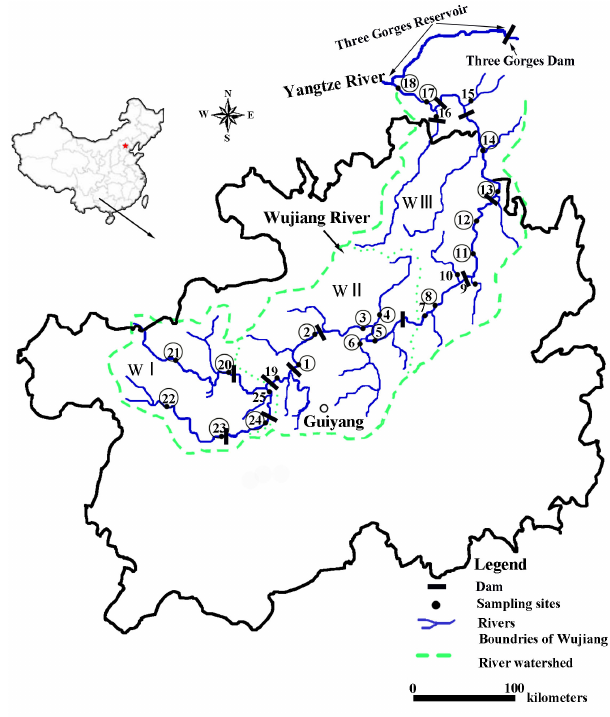
Figure 1. Location of sampling sites in the Wujiang River. Zones of W I, W II, and W III are the upper reaches, middle reaches, and lower reach, respectively. W I is dominated by Permian and Tri- assic carbonate rocks and basalt with coal-bearing formations out- crop in west. W II is dominated by Permian and Triassic limestones, dolomitic limestones, and dolomites. W III is distributed carbonate rocks intercalated with detrital rocks (shales, sandy shales, and silt-